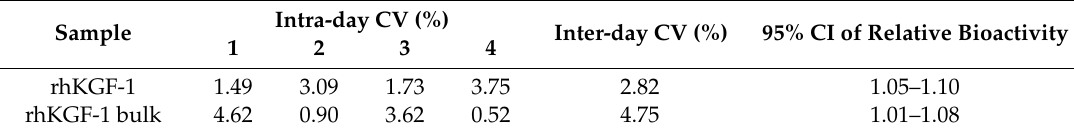
Table 2. The repeatability of final and bulk rhKGF-1 samples.